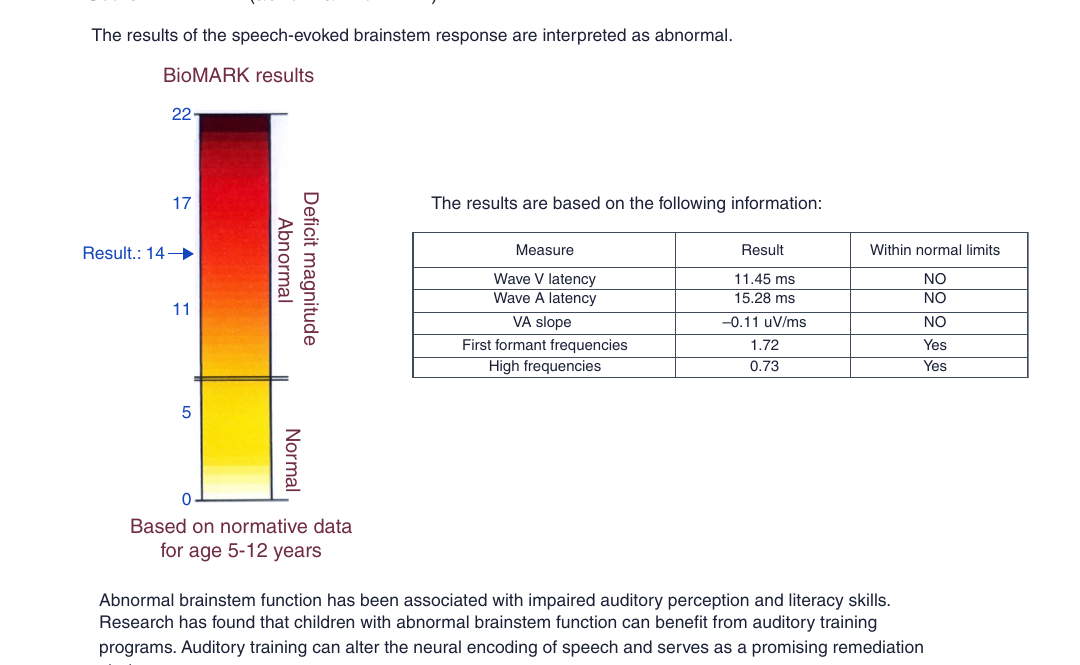
Figure 3 Auditory brainstem response (ABR) with speech stimulus and abnormal responses. Researcher’s data from a male patient (11 years